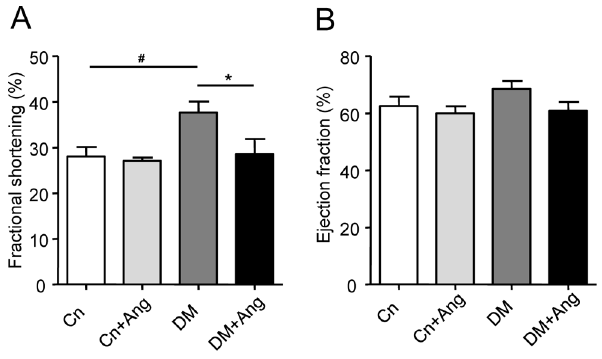
Figure 2. Effect of AngII-induced hypertension on cardiac function in non-diabetic and diabetic mice. Left ventricular fractional shortening (A) and ejection fraction (B) as determined by echocardiography in non-diabetic (Cn) and diabetic (DM) mice treated with vehicle or AngII (Ang) for 4 weeks (age 18 weeks). Data are analyzed by one-way ANOVA with Bonferroni post-hoc testing and expressed as mean 6 SEM (n = 7–9 per group). * refers to effect of AngII in non-diabetic and diabetic mice (* P , 0.05) and # refers to effect of diabetes in vehicle-treated and AngII-treated mice ( # P , 0.05, ## P , 0.01, ### P ,